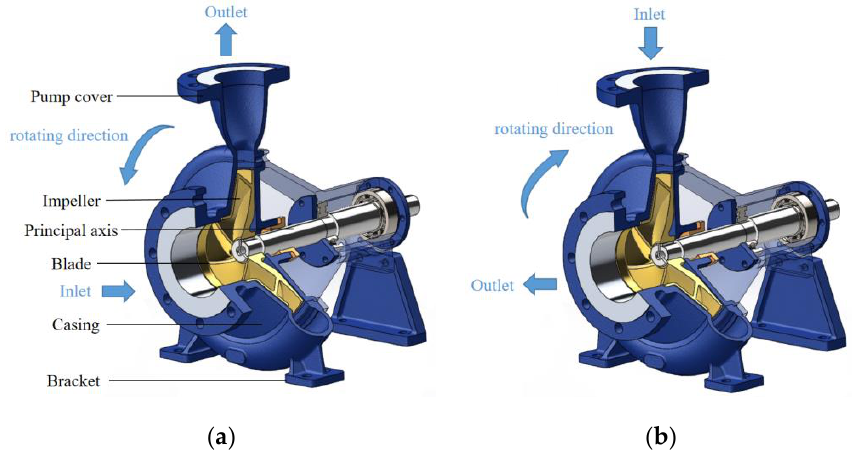
Figure 4. Single-stage centrifugal pump. ( a ) Pump modes; ( b ) pump as turbine (PAT) modes Table 1. Design specifications of the pump. Table 1. Design specifications of the pump.